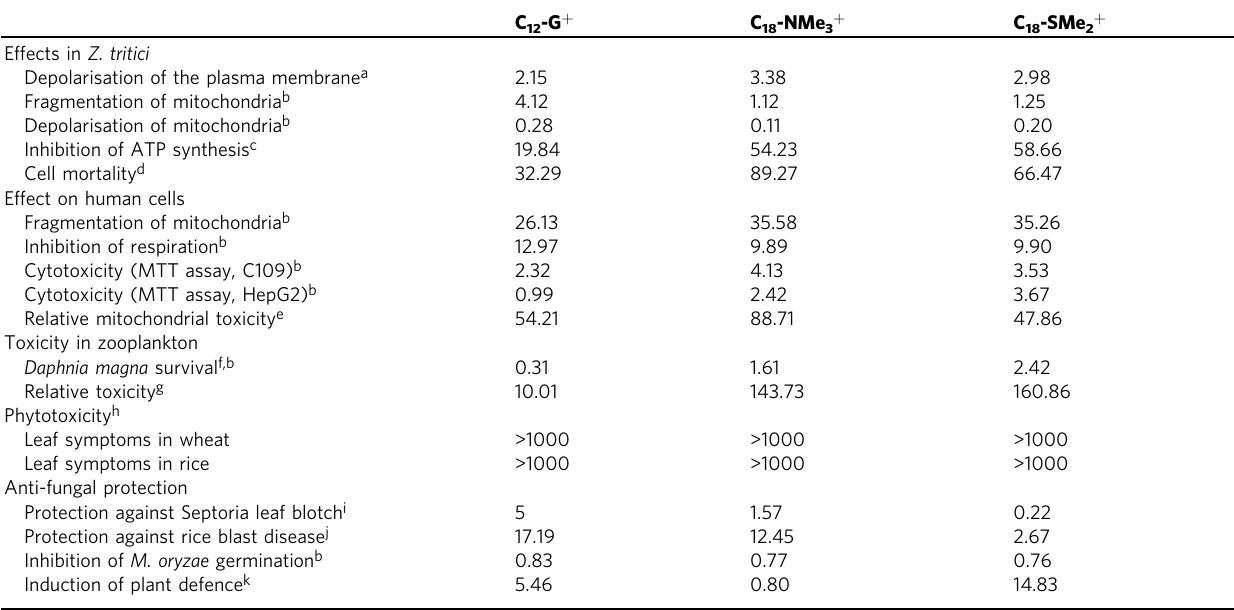
Table 1 Anti-fungal activity and toxicity of